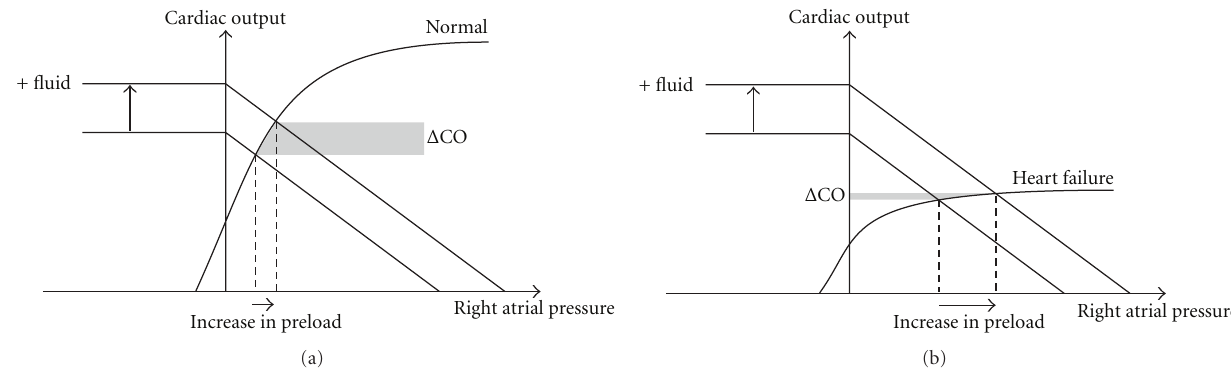
Figure 4: The e ff ect of fluid administration on cardiac output. Fluid administration results in an upward shift in venous return curve. As a result, there is an increase in preload hence cardiac output ( Δ CO) (a). Note that the crossing points between the two curves are on the steep part of the cardiac function (Frank-Starling) curve. In heart failure, the Frank-Starling curve is lowered, and the crossing point is at the flat portion of the curve (b). Fluid administration, although it increases the preload, does not result in an increase in CO in the latter case.